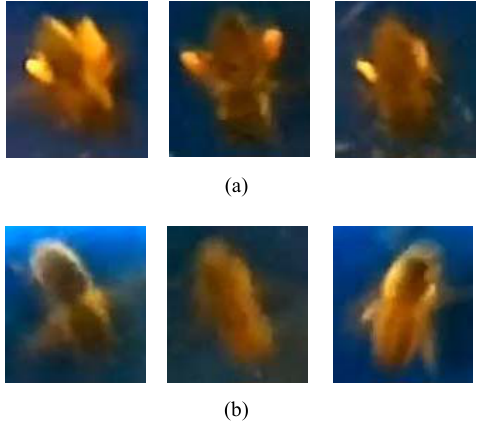
Figure 4. Parts of video frames with (a) pollen bearing honey bee, (b) honey bee without pollen load (best viewed in color)